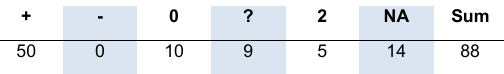
Figure 2. The Big List – Percentages of studies per application field